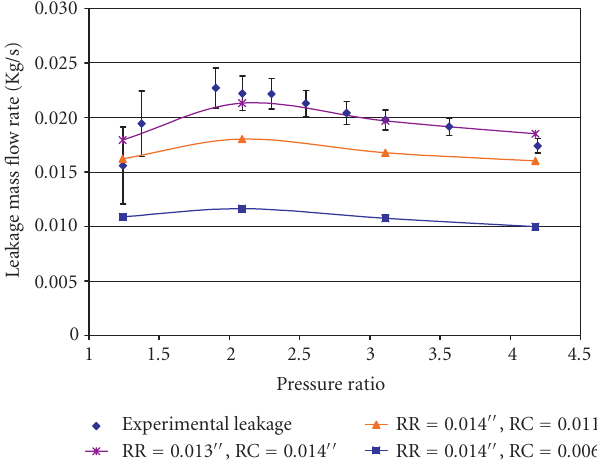
Figure 16: Comparison of computational and experimental leakage for di ff erent clearance combinations.